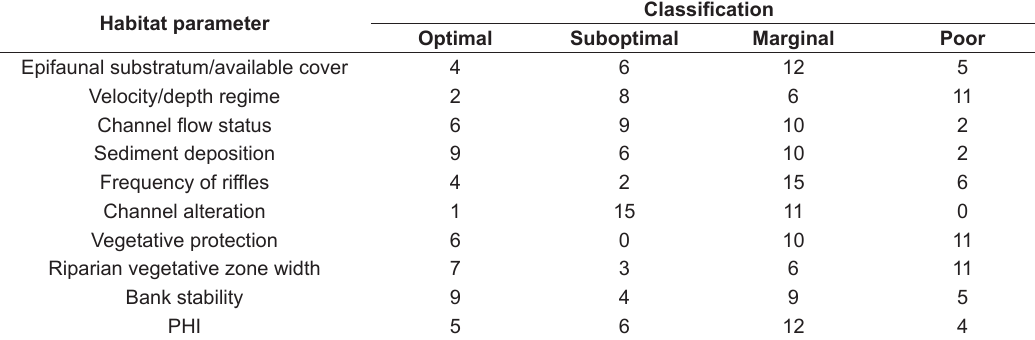
Table 4. Number of stream stretches by physical habitat index (PHI) parameter classification. Habitat